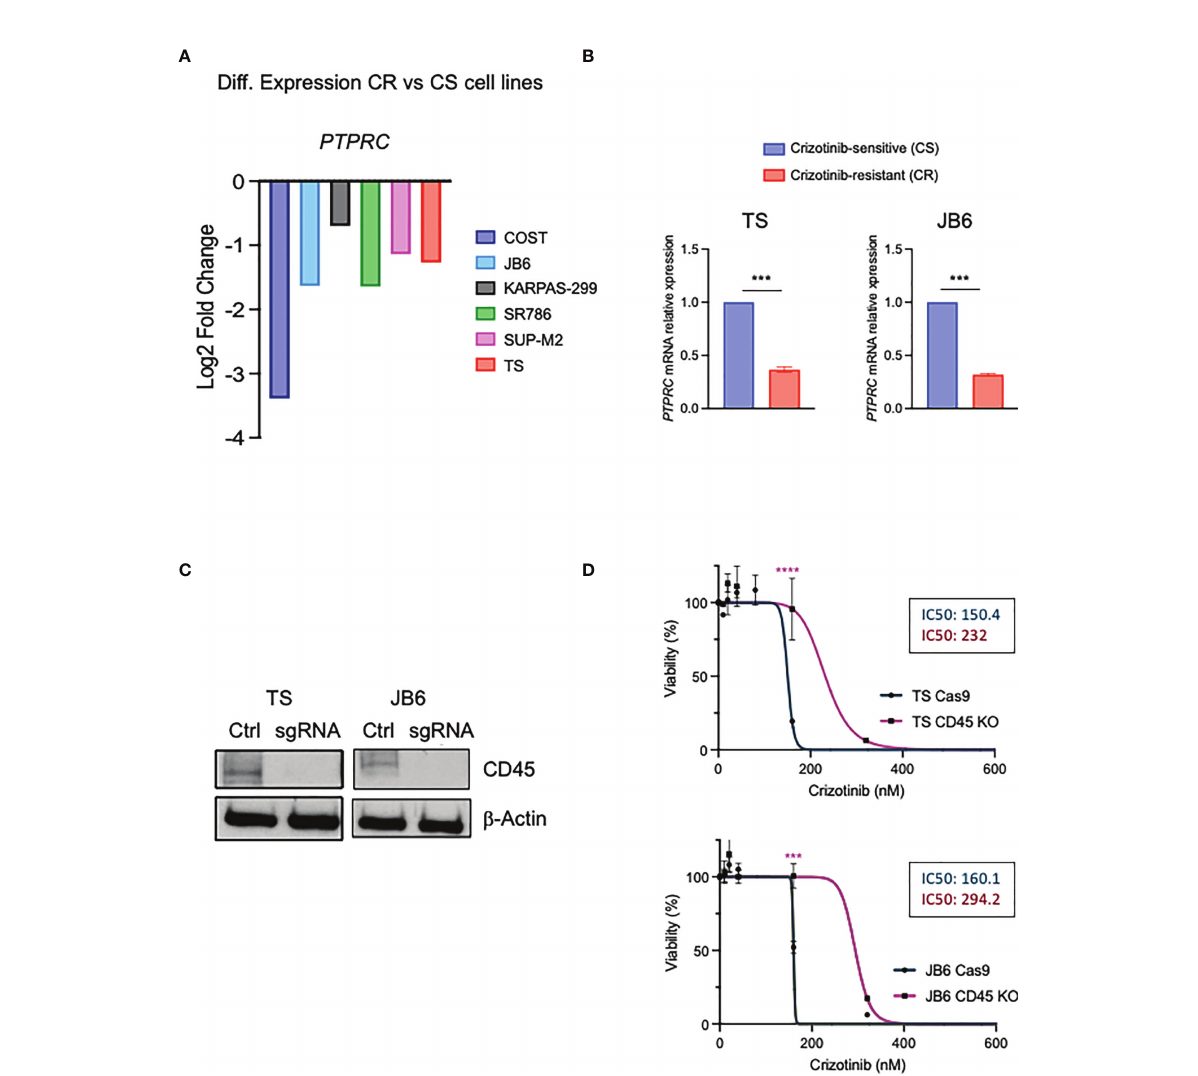
FIGURE 4 CD45 contributes to crizotinib resistance in ALCL. (A) Differential expression levels of PTPRC gene based on the RNA-seq data in paired crizotinib-sensitive (CS) and crizotinib-resistant (CR) ALK+ ALCL cells. (B) qRT-PCR analysis of PTPRC (CD45) mRNA expression performed on crizotinib-sensitive (CS) and crizotinib- resistant (CR) ALK+ ALCL cell lines (TS and JB6). PTPRC mRNA relative expression to paired CS cells is shown. Data are shown mean ± s.d., n=3 technical replicates. (C) Immunoblot analysis of TS and JB6 infected with a sgRNA targeting ex7 of PTPRC gene (see Materials and Methods) to obtain CD45 knock out cells. Cell lysates were blotted with the indicated antibodies. b -actin was used as a loading control. (D) Dose-response curves of ALK+ ALCL cell lines CD45 knock out (TS and JB6) treated with increasing concentrations of crizotinib for 72 h. Data are shown mean ± s.d., n=3 technical replicates. ***P<0.001, ***P<0.0001. Signi fi cance was determined by unpaired, two tailed Student ’ s